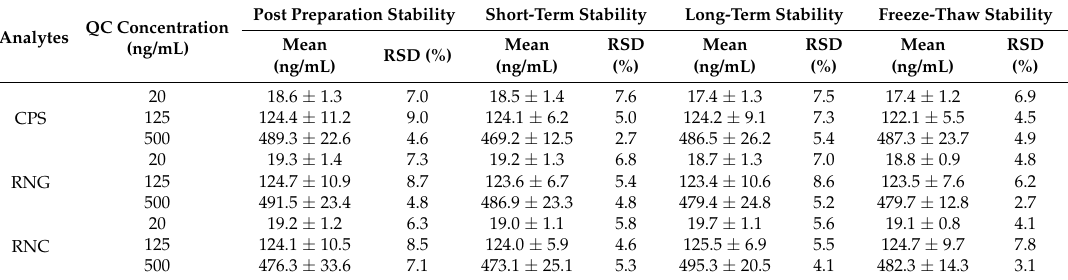
Table 4. The stability test of CPS, RNG, and RNC in rat plasma ( n = 6). Analytes QC Concentration (ng/mL)